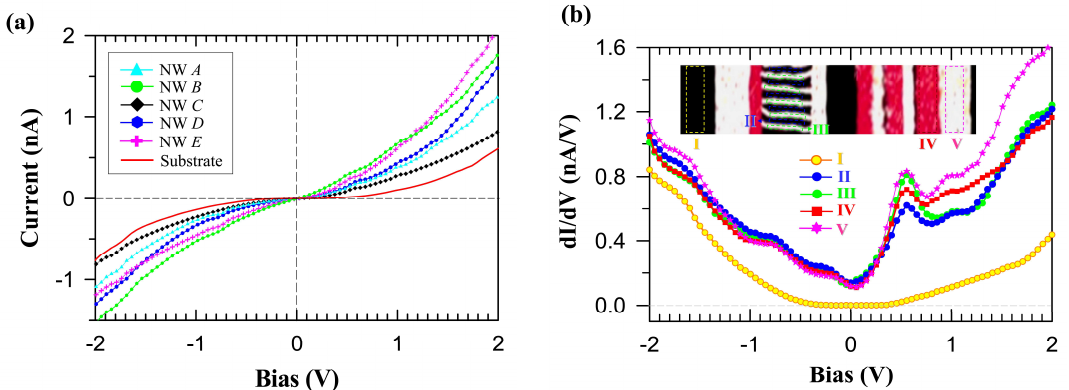
Figure 4. Auger electron spectroscopy (AES) of the Fe-silicide NWs on Si(110).